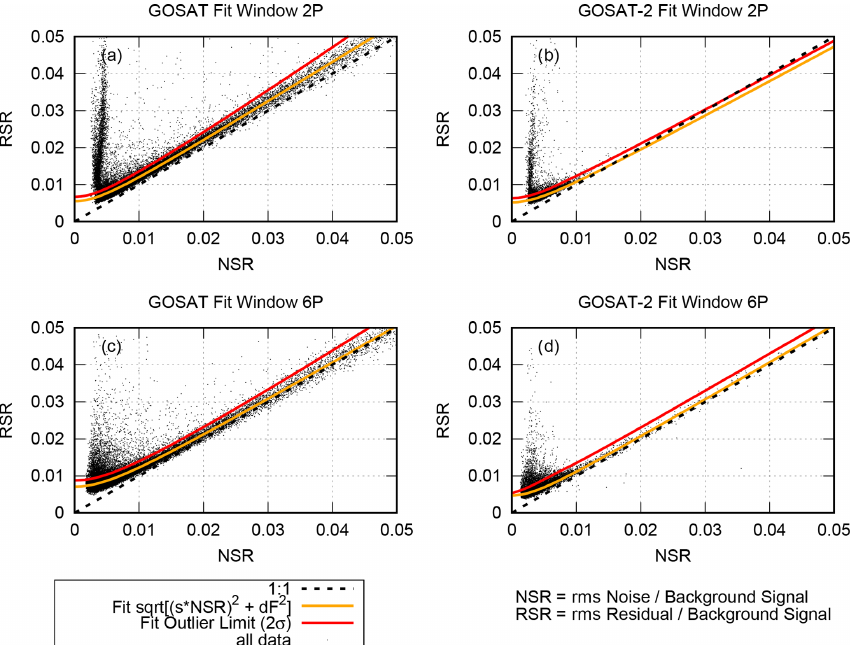
Figure 4. Example results from the noise model. (a) GOSAT fit window 2P. (b) GOSAT 2 fit window 2P. (c) GOSAT fit window 6P. (d) GOSAT 2 fit window 6P. Table 6. Parameters of the GOSAT noise